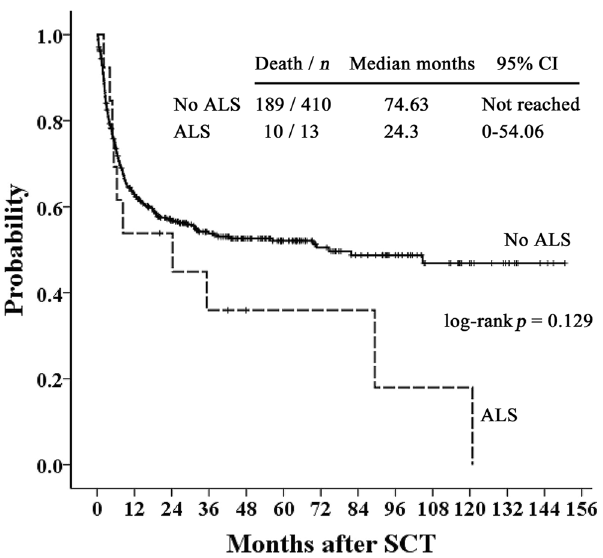
Figure 1. Kaplan–Meier curves of overall survival of patients with or without post-transplant thoracic